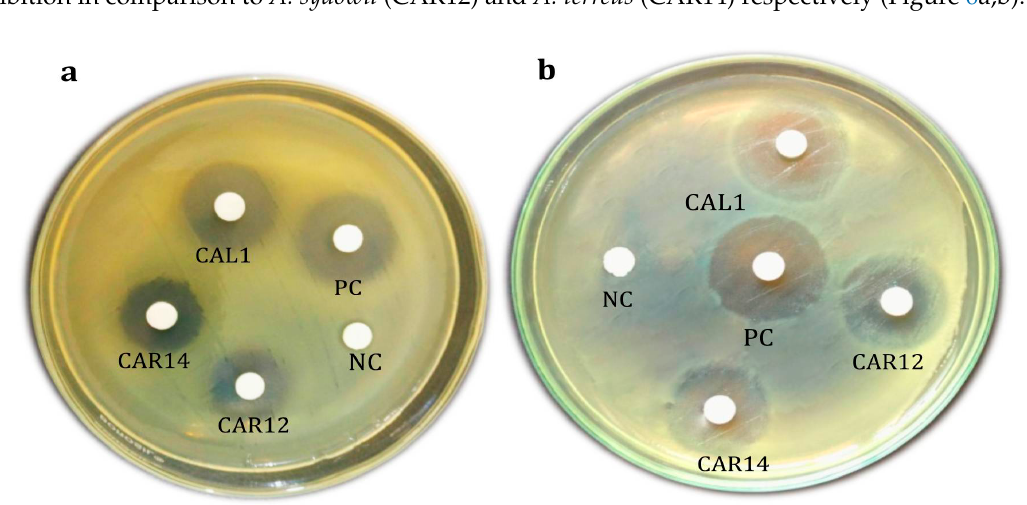
Figure 6. Antibacterial activity of endophytic fungal siderophores on plant pathogens ( a ) Ralstonia solanacearum ( b ) Xanthomonas oryzae pv . oryzae.